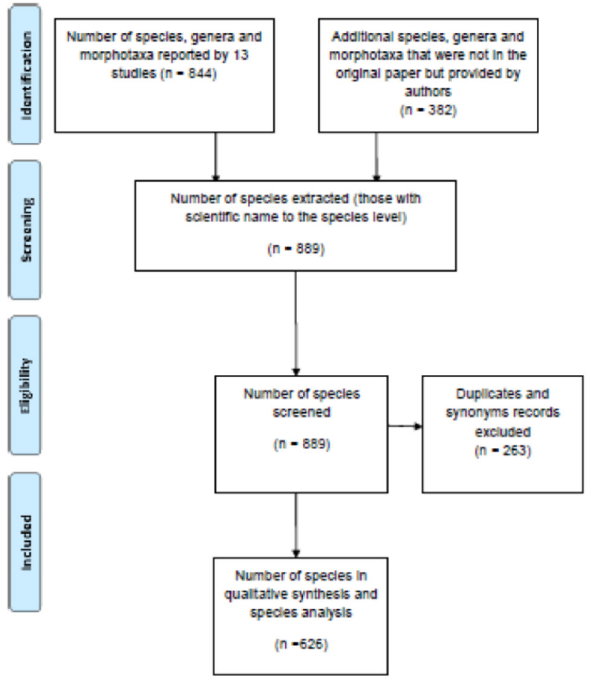
Figure 2. Flow chart using the PRISMA statement showing the steps involved in screening individual taxa. This was done to obtain a comprehensive list of species with seed collected from